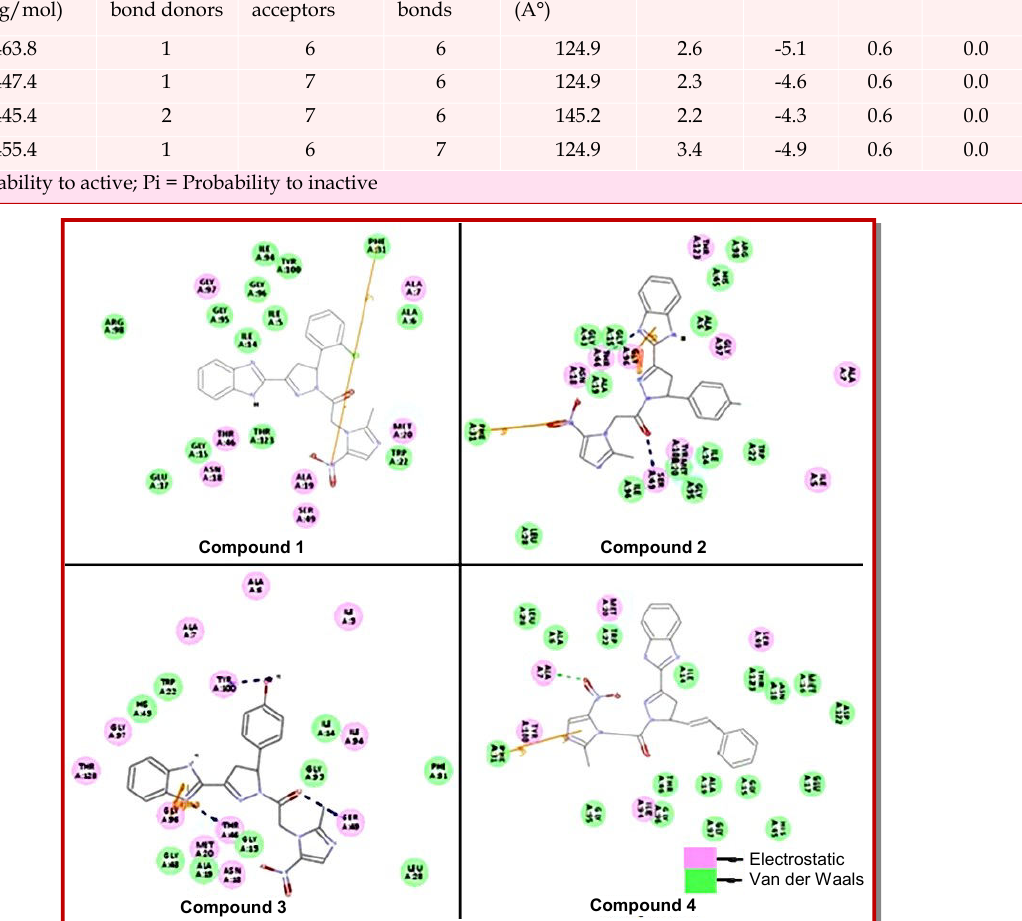
Figure 2: Binding configuration of synthesized derivatives (Discovery Studio 3.5